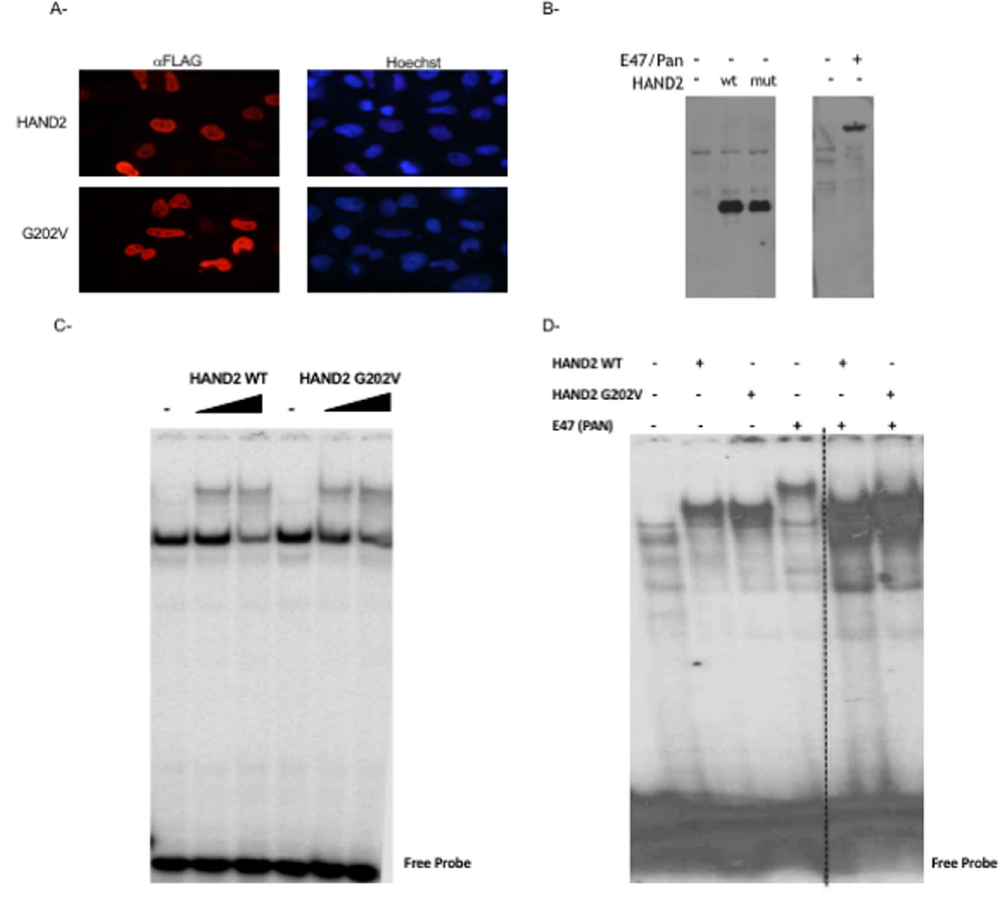
Figure 6. Characterization of the p.G202V protein in vitro . Transiently transfected Hela cells with plasmids harboring either the wild type HAND2 or the p.G202V variant were fixed and stained with an anti-Flag antibody. The secondary fluorescent antibody showed no change in the nuclear staining (in red) for both proteins as compared to the Hoechst staining (Magnification X40) ( A ). Western blot using the same anti-Flag antibody shows equal expression of both the wild type (wt) and mutated (mut) proteins in Hek293 cells, as well as the transiently overexpressed E47/Pan protein ( B ). Gel Shift analyses with increasing doses from the same nuclear extracts as in ( C ) were used on a consensus HAND binding site showed similar pattern of binding for both the wild type and mutant HAND2 proteins ( D ). The same pattern was observed when mixing the same amount of the HAND2 proteins with E47/Pan. The panel was separated by dotted lines to highlight the fact that the presented figure is a merge of two different gels run